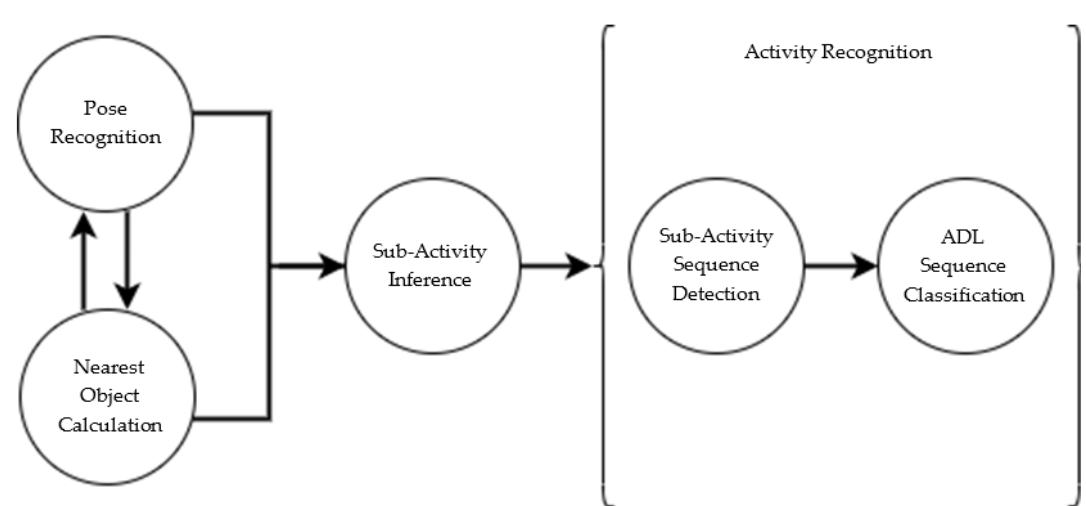
Figure 1. Our frame work for the production of an Activity of Daily Living (ADL) recognition approach where the pose recognition stage is investigated in this work.